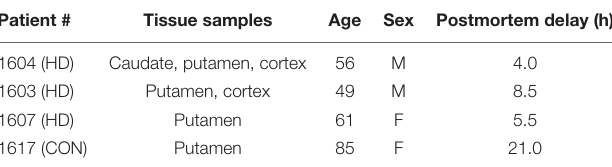
TABLE 1 | Brain tissues samples used in pre-clinical evaluation. Patient # Tissue